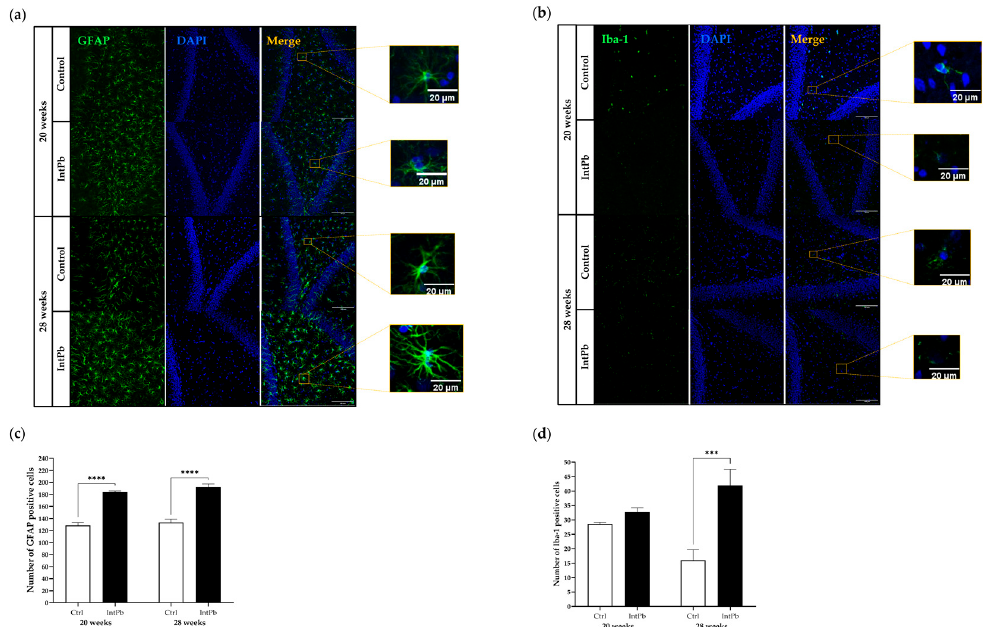
Figure 5. Neuroinflammation evaluated through astrocytic (GFAP) and microglial (Iba1) markers by immunohistochemistry. ( a ) Representative images of the GFAP (1:500) ‐ stained astrocytes. ( b ) Quantification of GFAP ‐ positive cells. ( c ) Representative images of the Iba1 (1:250) ‐ stained microglia. ( d ) Quantification of Iba1-positive cells. Images were acquired using a confocal point scanning microscope (Zeiss LSM 880 with Airyscan) with a 20 × objective. The scale bar is 50 µ m or 20 µ m for stained images. Values are expressed as the mean ± SD for n IntPb = 3–4 and n Ctrl = 3–4 for each evaluated time-point. The symbols denote statistically significant differences inter groups (Ctrl vs. IntPb—*** p < 0.001, **** p < 0.0001); two-way ANOVA, Tuckey’s multiple comparison